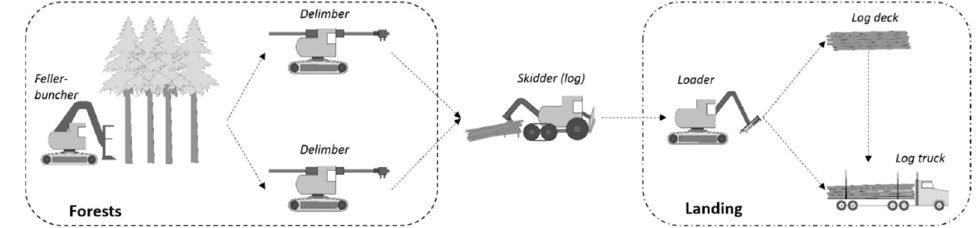
Figure 4. Description of the lop-and-scatter system used in Colorado State Forest State Park.